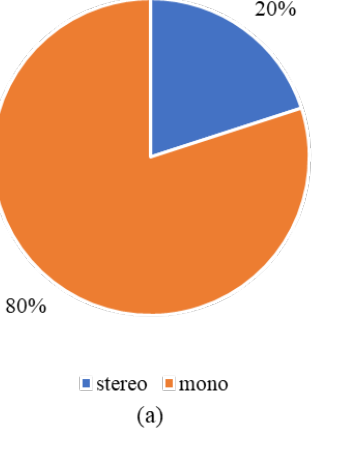
Figure 7. The distribution by camera model and image format in the Included Study . ( a ) Refers to the ratio of the monocular camera model in the Included Study . ( b ) Refers to the distribution by image format in the Included Study . Table 9. The study of the distribution by camera model in Figure 7a.